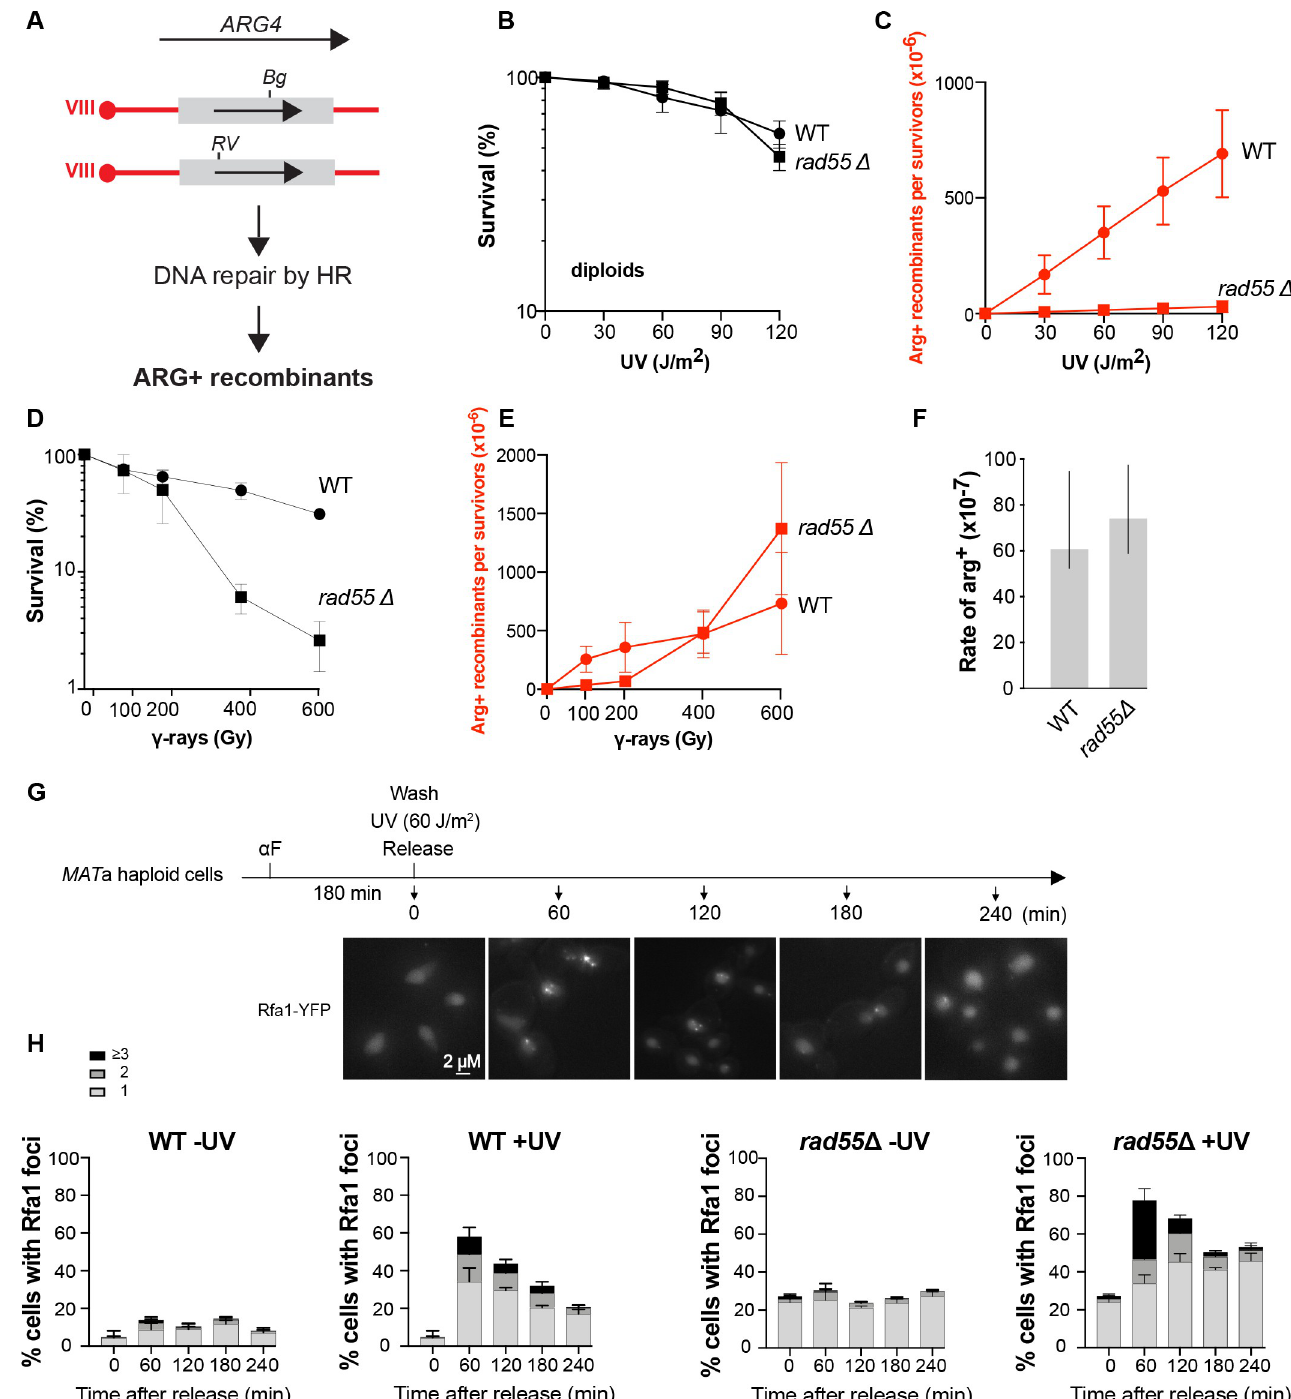
Fig 1. Rad55 plays a major role in UV-induced HR. (A) Schematic representation of the genetic system used. Frameshift mutations were introduced at the Eco RV site (RV, ± 2 bp) or the Bgl II site (Bg, +4 bp). HR between the two ARG4 mutant alleles can restore a WT ARG4 allele associated with the [Arg+] phenotype. (B) Survival and (C) [Arg+] recombinant frequencies after UV exposure of WT and rad55 Δ diploid cells. (D) Survival and (E) [Arg+] recombinant frequencies after γ irradiation of WT and rad55 Δ diploid cells. (F) Spontaneous mitotic [Arg+] recombinant rates ([Arg+] x 10 − 7 /cell/generation) of WT and rad55 Δ diploid strains. (G) Experimental scheme for microscopy analysis of RPA foci: Cells arrested in G1 phase with alpha-factor ( α F) were exposed to UV before release into the cell cycle. Samples were collected for analysis every hour for four hours. Representative images of Rfa1-YFP cells are presented. Scale bars are 2 μ m. (H) Quantification of Rfa1-YFP foci detected by fluorescence microscopy in WT and rad55 Δ cells exposed or not to UV. Error bars indicate SDs from three independent experiments.